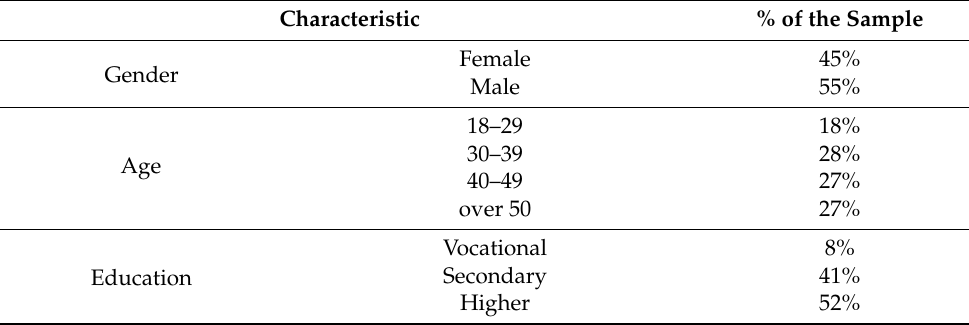
Table 1. Structure of the research